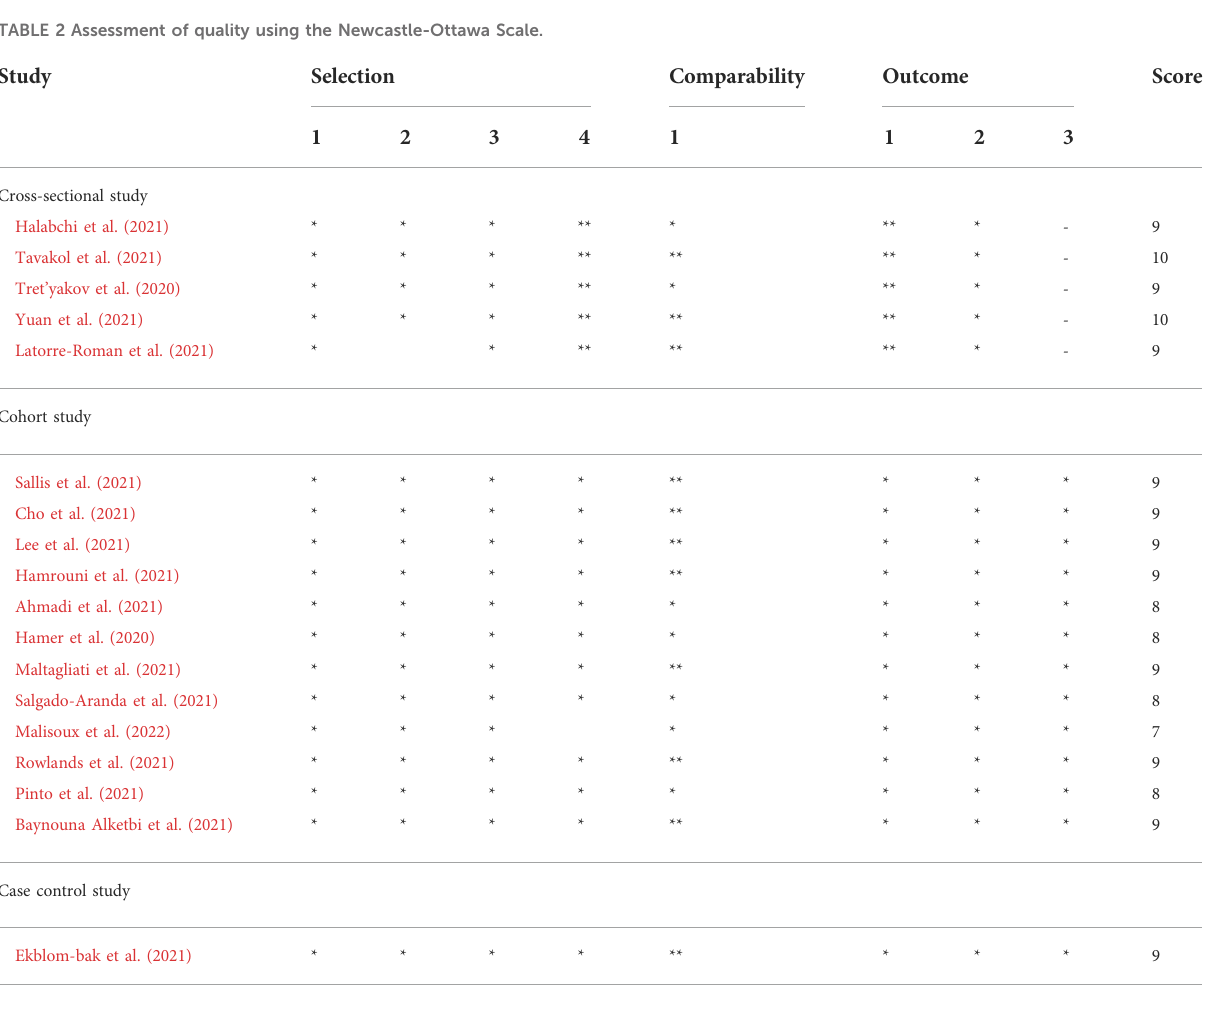
(Figure 2). As assessed by the funnel plot (Supplementary Figure S1), there was no apparent systematic bias (Egger ’ s test for bias: p = 0.472; Supplementary Figure S2).